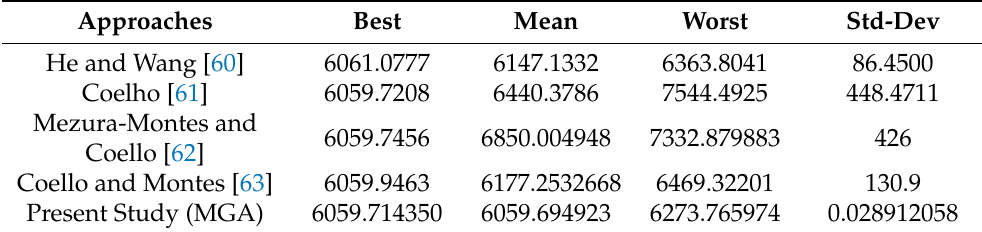
Table 10. Statistical results of different approaches for the pressure vessel design problem.